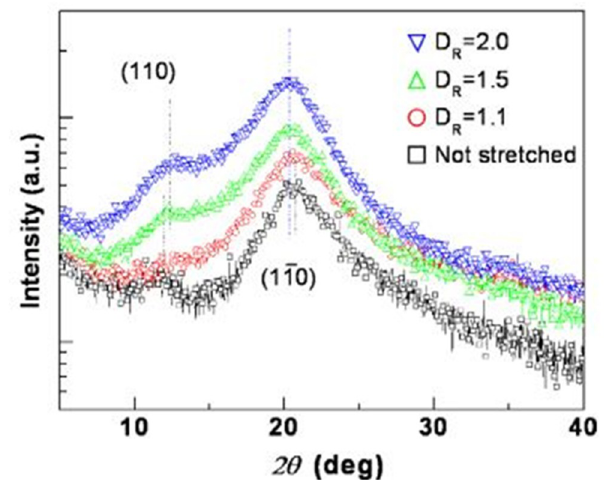
Figure 8. X‐ray diffraction data of the stretched cellulose film with different stretching ratios [50].